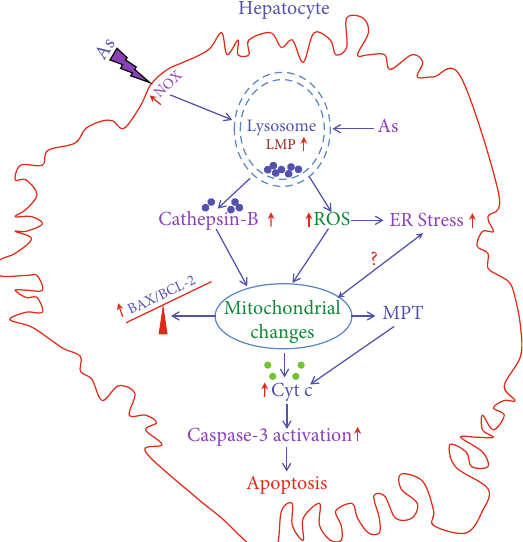
Figure 7: Schematic diagram of the proposed cellular events during arsenic exposure to hepatocytes. Arsenic exposure to hepatocyte causes activation of plasma membrane-bound NOX and generation of ROS in the cell. Both ROS and arsenic cause leakage of lysosomal membrane leading to LMP resulting in release of cathepsin B and increased ROS generation. Both cathepsin B and increased ROS in turn cause mitochondrial changes leading to rapid onset of MPT that is upstream of cytochrome c release as well as increase in BAX and BCL-2 ratio. Cytochrome c further promotes the e ff ector caspase activation leading to apoptotic death of hepatocytes. Increased ROS causes induction of ER stress at a later time period, and the role of ER stress in mitochondrial functional changes in our study is